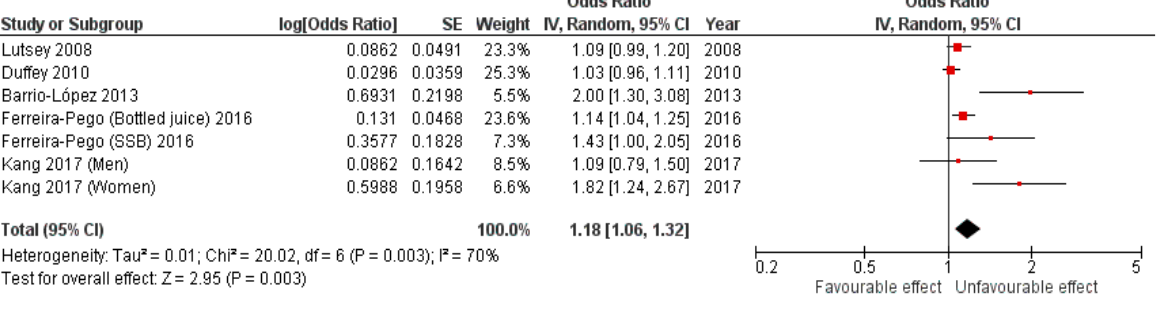
Figure 3. Cohort studies forest plot.